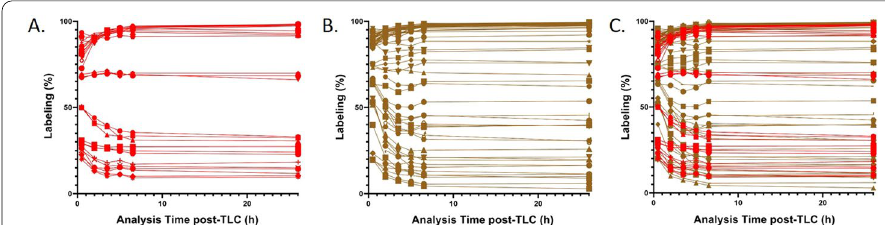
Fig. 3 Plot of radiolabeling yield versus measurement time after TLC for multiple reaction